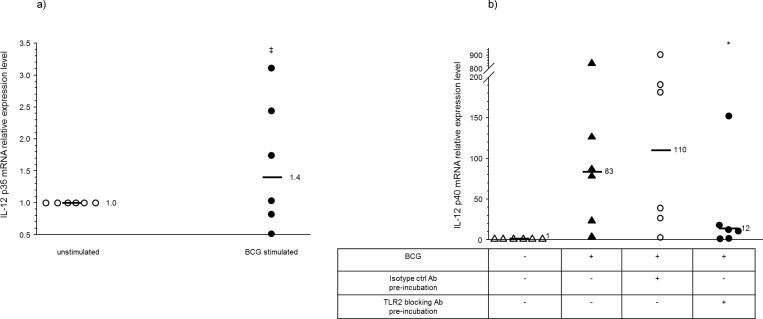
Bacille Calmette Guérin (BCG) does not induce IL-12 p35 mRNA production from human neonatal monocyte-derived dendritic cells (mdDCs), but induces IL-12 p40 mRNA production in a Toll-like receptor (TLR)2-dependent manner.Human umbilical cord blood CD14+ monocytes were differentiated into mdDCs using rIL-4 and rGM-CSF, stimulated with BCG x 18–24 hours, and then cellular mRNA was isolated for qRT-PCR. (a) relative expression of IL-12 p35 mRNA levels upon BCG stimulation compared to unstimulated control. Bars are median values, ‡ p = 0.3, n = 6 independent experiments; (b) relative expression of IL-12 p40 mRNA levels upon BCG stimulation compared to unstimulated control, in the presence or absence of a TLR2 blocking antibody. Bars are median values, * p<0.05 compared to BCG stimulation with isotype control antibody pre-incubation, n = 6 independent experiments.